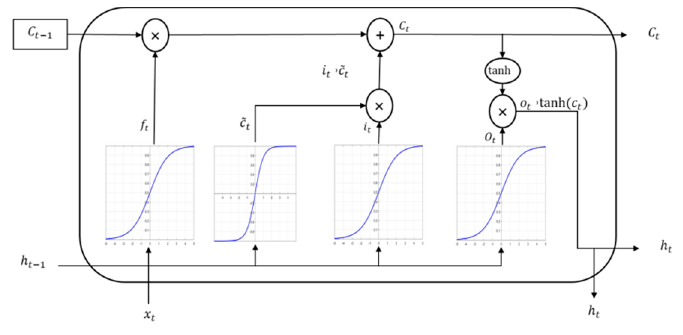
Figure 4. LSTM structure.